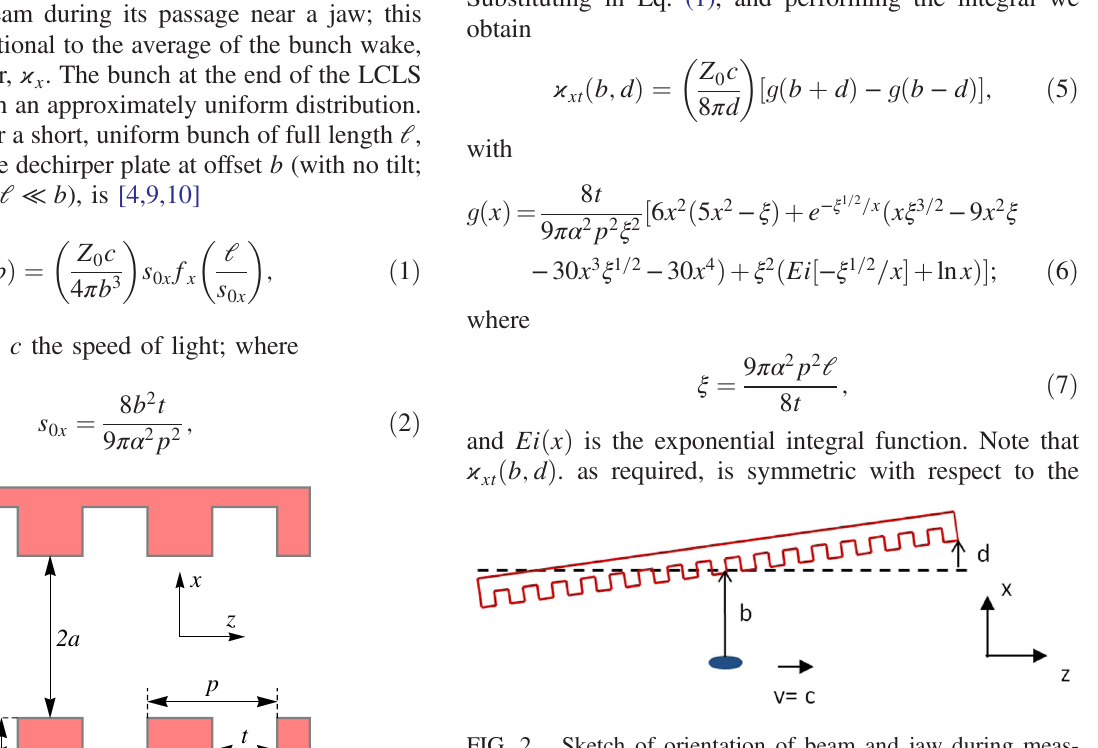
FIG. 2. Sketch of orientation of beam and jaw during meas- urement (for a horizontal jaw). The beam (blue ellipse) moves in the z direction below the dechirper jaw (red), at average offset b ; the jaw tilt (with respect to z ) is defined by the change in offsets at the jaw ends, (cid:1) d . Note that the corrugation size and tilt angle as sketched are much larger than they are in